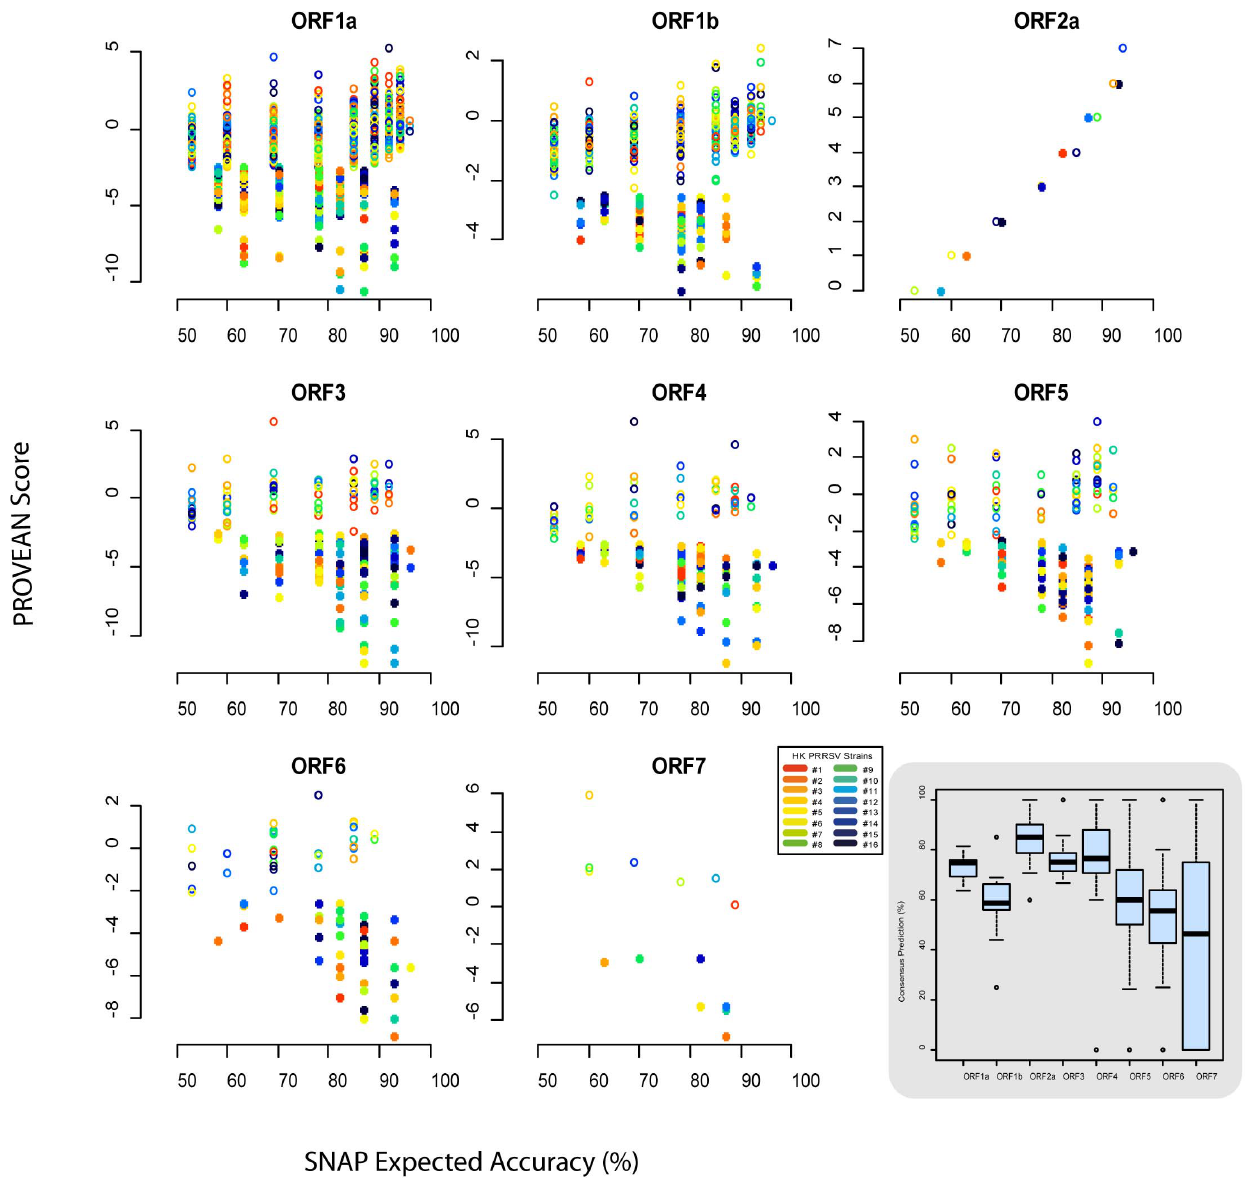
N Figure 4. Predicted effect of minor nonsynonymous variants on the protein structure of different PRRSV ORFs. Predicted effects were ) only when such effects were independently confirmed by PROVEAN and SNAP tools. Variants classified as being either neutral ( # ) or non-neutral ( which had differing predicted effects by the two software tools were excluded. For PROVEAN, ‘‘neutral’’ designation was assigned when a score higher than 2 2.5 was obtained and ‘‘non-neutral’’ when lower. Confidence of predictions made by SNAP is indicated by the expected accuracy score generated by the tool. Results are summarized based on individual ORFs (first eight panels) and viral strains (color legend, panel 8). The distribution of consensus predictions (out of total predictions) by the two programs across ORFs of different strains is summarized in the last panel as boxplots (bottom right).